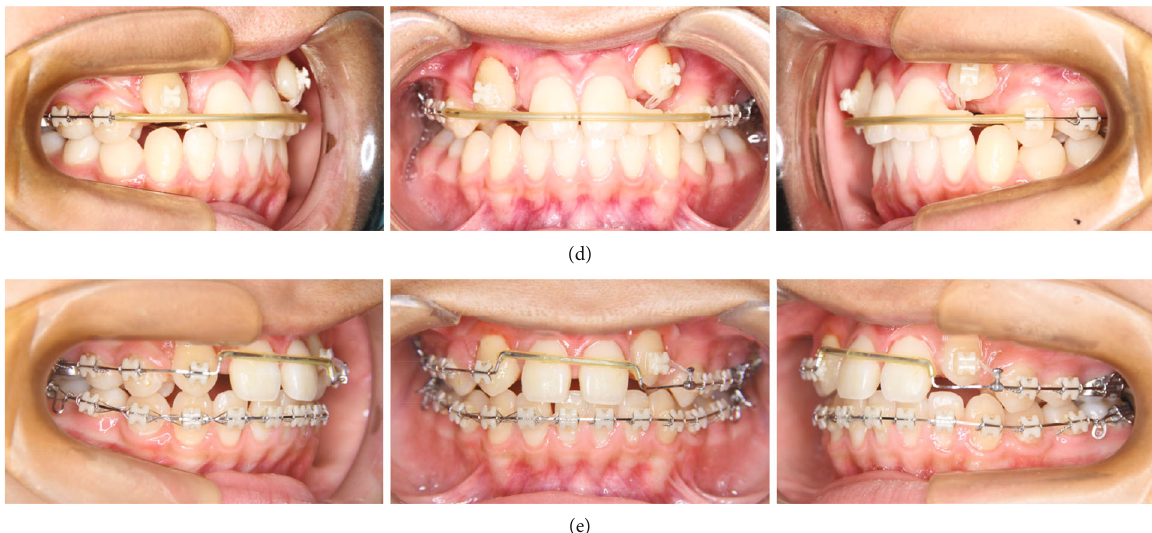
Figure 5: (a – c) Following completion of canine reposition. Facial and intraoral photographs and panoramic radiograph, (d and e) treatment